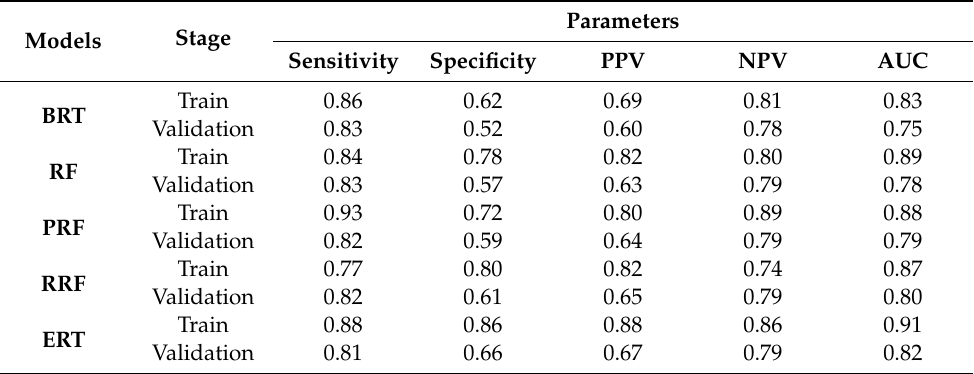
Figure 7. The receiver operating characteristic (ROC) curve analysis for five flash flood susceptibility models using the validation dataset. Table 3. Predictive capability of piping models using train and test